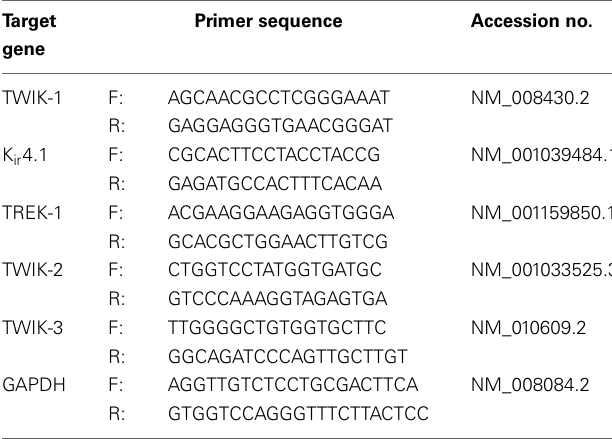
Table 1 | Primers for qRT-PCR analysis.